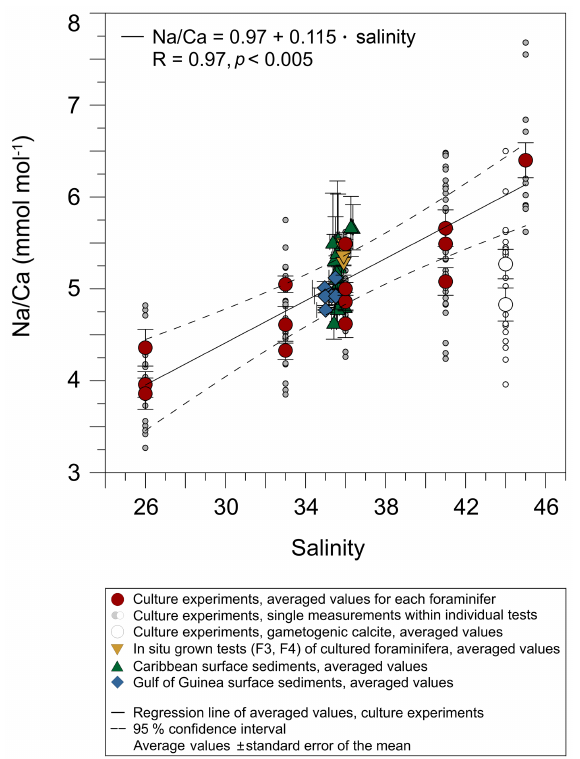
Figure 4. Na / Ca values of cultured T. sacculifer increase signif- icantly with increasing salinity, while the temperature remained constant (26.5 ◦ C ± 0.25 ◦ C). Each grey data point comprises av- eraged Na / Ca values of single map electron microprobe analy- sis along inner chamber wall cross sections of newly grown cal- cite (F, F-1) during the experiments. Red dots indicate averaged Na / Ca values of one foraminifer. Related data on individual mea- surements for the salinity experiments are given in Table 3. Datasets for T = 26 . 5 ◦ C of both temperature experiments ( S 36, S 33) were added (Tables 4, 5). Within each experiment Na / Ca values are nor- mally distributed (Shapiro–Wilk test; Appendix A). The solid line marks the regression line of red-colored average values. Pearson’s correlation coefficient R and its significance ( p ) is based on these averaged values. Dashed lines indicate the 95% confidence interval. White data points represent results of the 44 salinity experiment, in which cultured foraminifera underwent gametogenesis (Nürnberg et al., 1996) and were hence excluded from the regression. Yellow reversed triangles indicate Na / Ca foram values from in situ grown chambers (F-3, F-4) before culturing (annual salinity: ∼ 35 . 9, tem- perature: ∼ 27 . 4 ◦ C; WOA13; Table 3). Blue squares mark Na / Ca values of T. sacculifer from Gulf of Guinea surface sediments (Ta- ble 1). Green triangles are data from Caribbean surface sediments (Table 1). Data marked by yellow, blue, and green symbols are not included in the calculation of the regression. All vertical error bars are based on the standard error of the mean. Horizontal error bars of samples from the Gulf of Guinea and the Caribbean (here as small as the symbol sizes) demonstrate the salinity gradient between 0 and 60m, reflecting the habitat range of T. sacculifer expressed as the standard error of the mean.